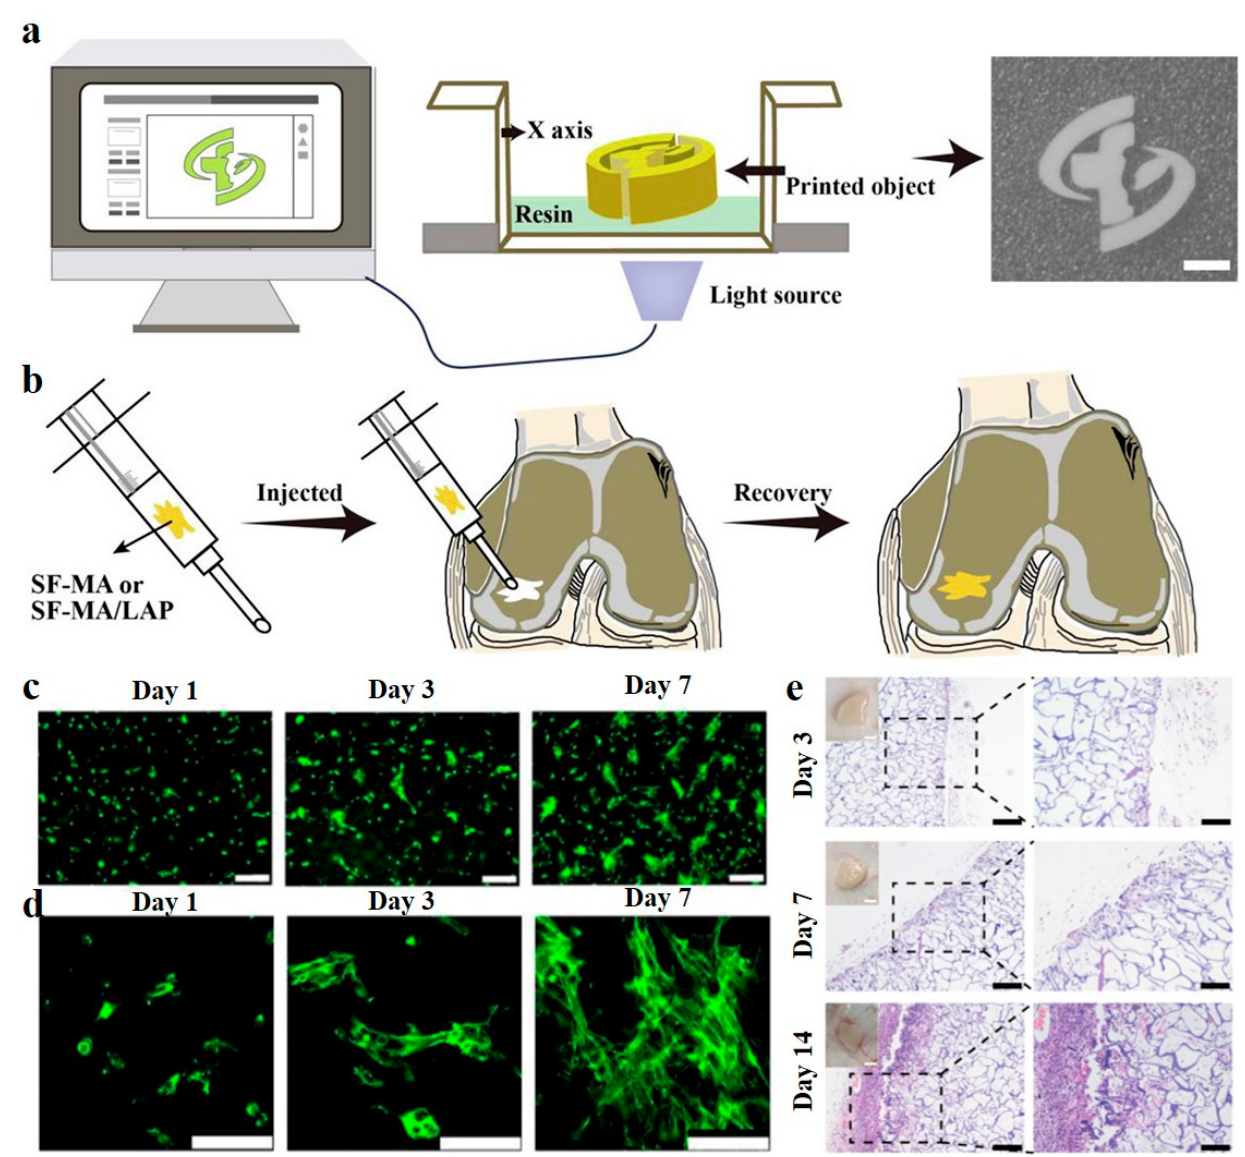
Figure 2. 3D Cryoprinting of LAP@SF injectable cryogels for bone tissue engineering. ( a ) Schematic illustration of the printing process of LAP@SF cryogels. ( b ) The printed cryogels can recover their original shape after injection and fit the tissue defect site. ( c ) Fluorescence staining image of live (green)/dead (red) BMSCs, after 1, 3, and 7 days of cultivation on the printed LAP@SF cryogels. Scale bar = 200 µm. ( d ) The morphology of BMSCs, after 1, 3, and 7 days of cultivation on the printed LAP@SF cryogels. Scale bar = 100 µm. ( e ) H&E staining of the printed LAP@SF cryogel scaffold after 3, 7, and 14 days of implantation; left, scale bar = 200 µm; right, scale bar = 100 µm. Reused with some rearrangement with permission of [74] (Under a Creative Commons license: CC BY-NC-ND 4.0).